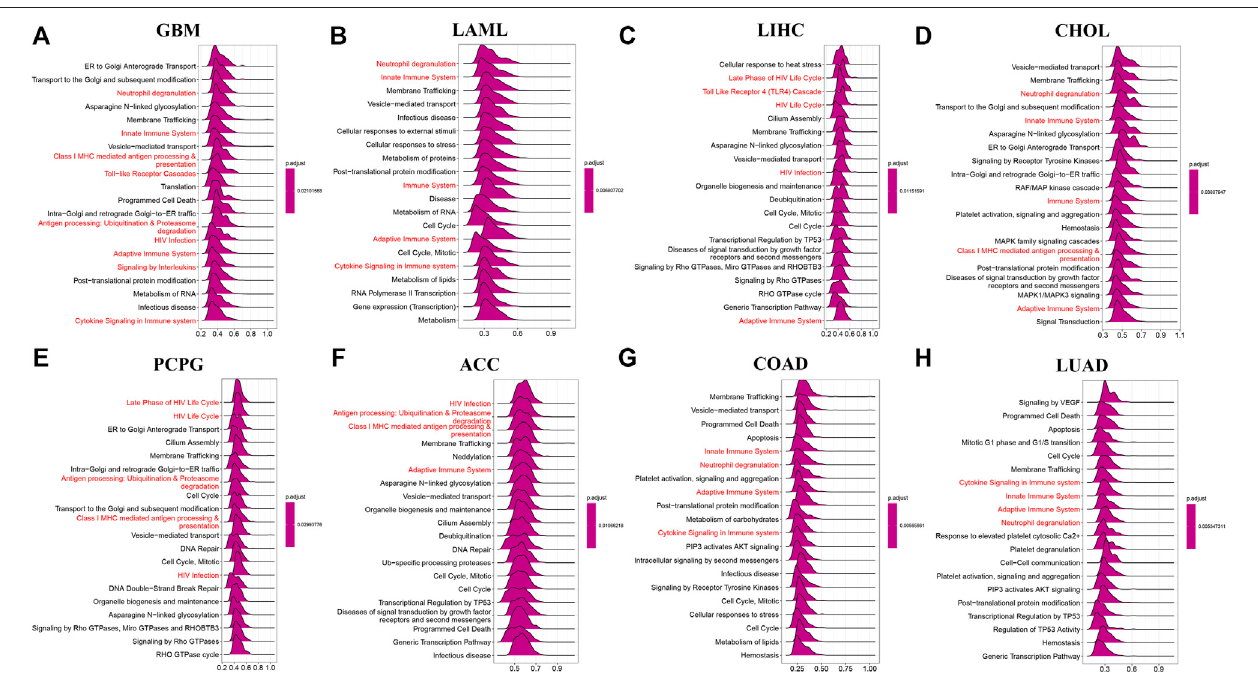
FIGURE 6 | GSEA of AP3S1 in TCGA pan-cancer. (A – H) The top 8 signi fi cant pathways of AP3S1 GSEA results across the indicated tumor types. Red color represents immune-related pathways.